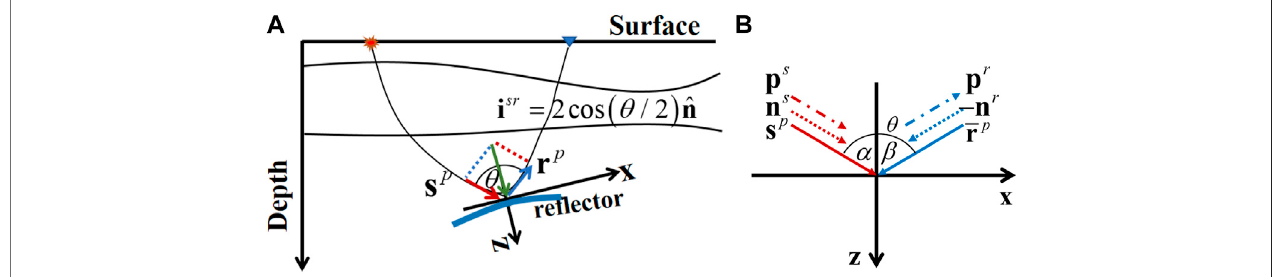
FIGURE 5 | The incident vector and re fl ected vector of pure P wave in observation coordinate system (A) and local coordinate system (B) . The coordinate observationsystemisconstructedalongthehorizontalsurfaceandverticaldepth.Theilluminationvector i sr ,usedtodescribetherelationshipbetweentheincidentwave andre fl ectedwave,isrelatedtotheverticaldirectionsofthere fl ectorandopeningangle.Tosimplifytheirrepresentation,thelocalcoordinatesystemisconstructedalong withtangential and verticaldirections ofthe re fl ector. Inalocal coordinate system, the incident vector and re fl ected vector canbe described bytheincidentangle α or opening angle θ .